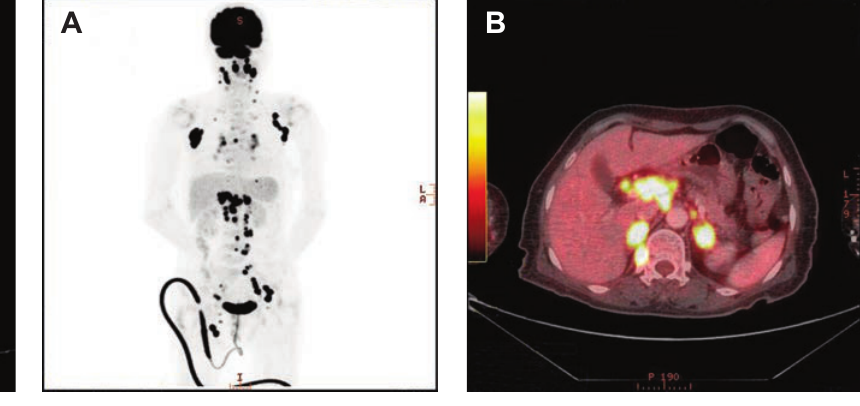
Figure 2. Contrast-enhanced CT scan shows mass-like enlargement and rim enhancement and focal cystic lesion of bilateral adrenal glands on axial images.